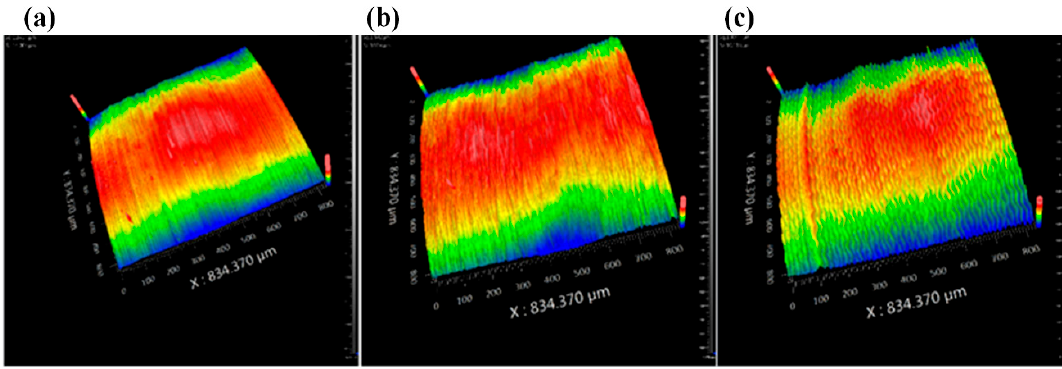
Figure 11. Surface topography (depth of cut, 0.05 mm) ( a ) CC, f = 0.005 mm/r, V = 200 m/min, ( b ) SVC, f = 0.005 mm/r, V = 200 m/min and ( c ) SVC, f = 0.02 mm/r, V =5 0 m/min.